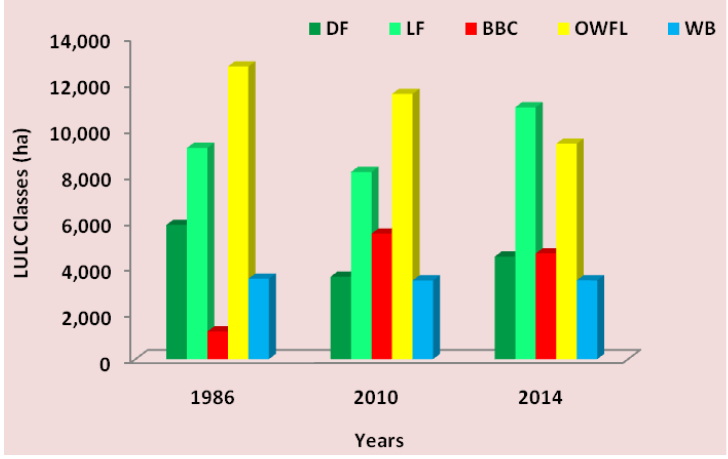
Figure 5. Grouped bar graph of the LULC Area (Ha) for 1986, 2010 and